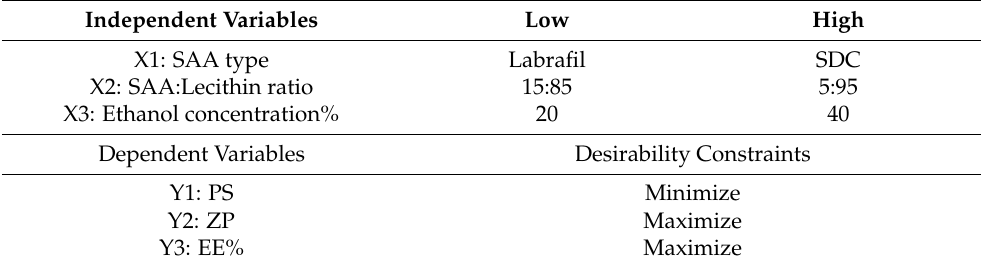
Table 1. Full factorial design (2 3 ) used for preparation and optimization of AzA-TEs. Independent